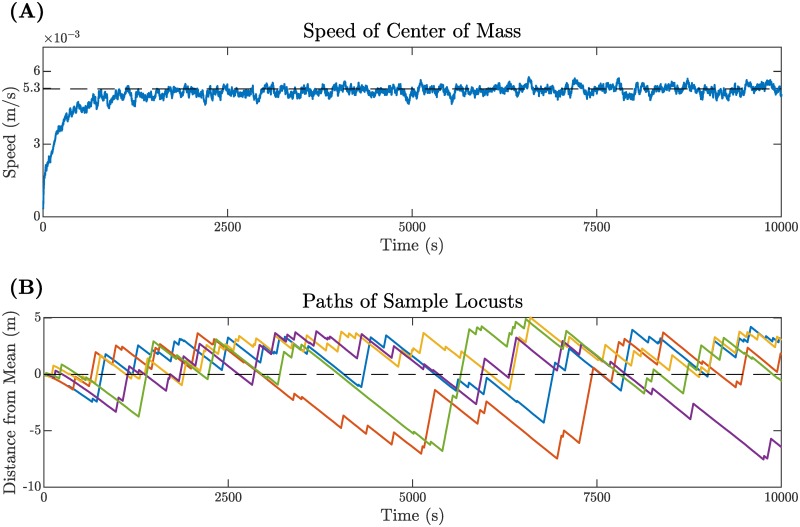
(A) Speed of the mean position of all locusts (center of mass of the swarm). Note the initial increase followed by a sustained period of variation around the average c = 5.3 × 10−3 m/sec. The standard deviation around c is 0.16 × 10−3 m/sec after transients. (B) Paths of five sample locusts, each shown in a different color. Note the initial transients appearing as curves near t = 0, after which all each path appears piece-wise linear with either positive or negative slope corresponding to when the given locust was in a moving or stationary state. Each locust spends some time ahead of the mean and some time behind it, reminiscent of the “leap-frogging” behavior noted in [4].